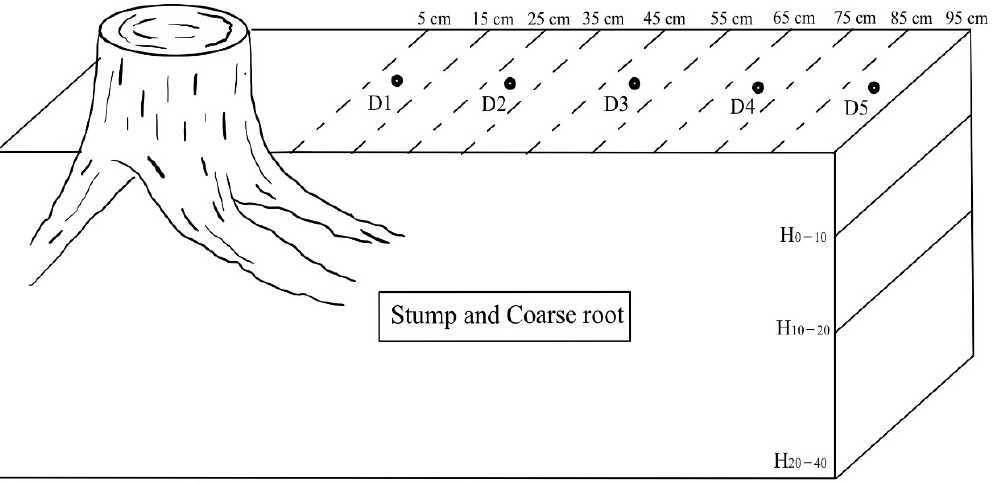
Figure 3. Illustration of the soil sampling design for each stump and coarse root. H denotes the depth of the soil layers, 0–10 cm, 10–20 cm and 20–40 cm. D1, D2, D3, D4 and D5 denote sampling points within horizontal distances of 5–15 cm, 25–35 cm, 45–55 cm, 65–75 cm and 85–95 cm from the stump and coarse root, respectively. Table 1. Basic characteristics of pure larch plantation and mixed larch–ash plantation.